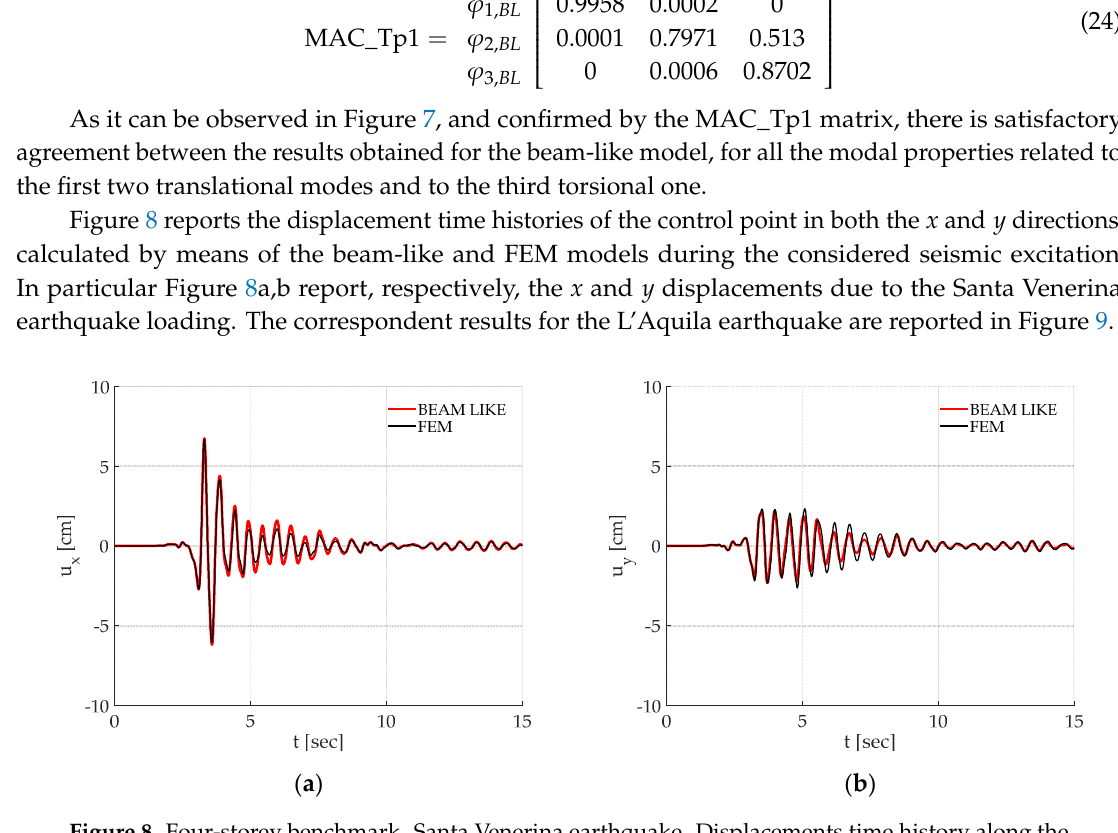
( a ) ( b ) Figure 9. Four-storey benchmark. L’Aquila earthquake. Displacements time history along the ( a ) x and ( b ) y direction. Once again, it must be remarked how the proposed approach is able to correctly reproduce the time history of a chosen point on the building. Finally, as it can be observed in Figure 10, also the maxima displacements of the same corner located at each floor, calculated by means of the beam-like model, give reliable results.